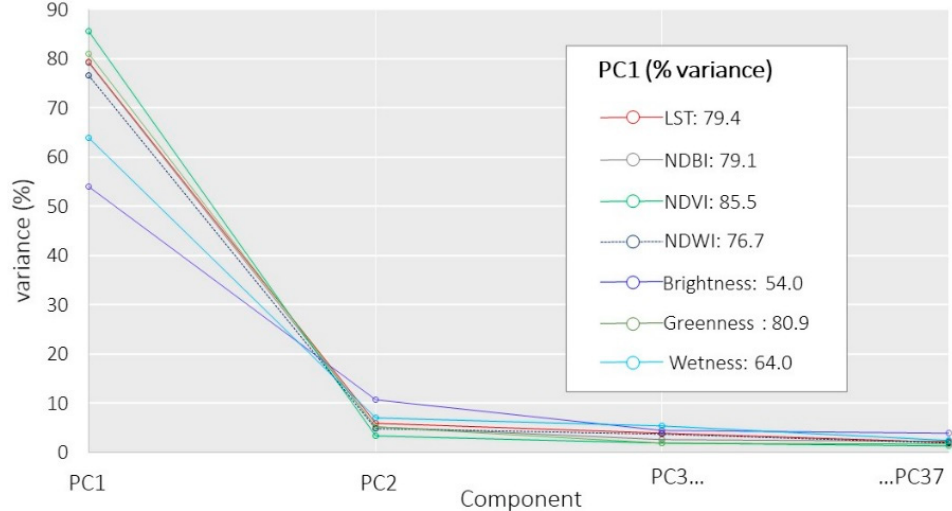
Figure 9. Contribution of the main PCA components to the total variance for the different variables used in this study.